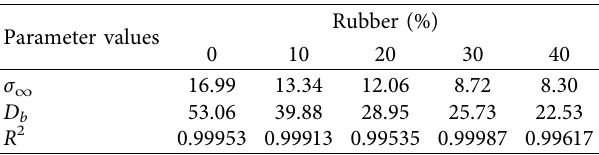
Figure 15: Rubber concrete equation of size effect law. (a) Size effect law equation and (b) unified equation of size effect law. Table 4: Mathematical regression parameter values of the size effect law of rubber